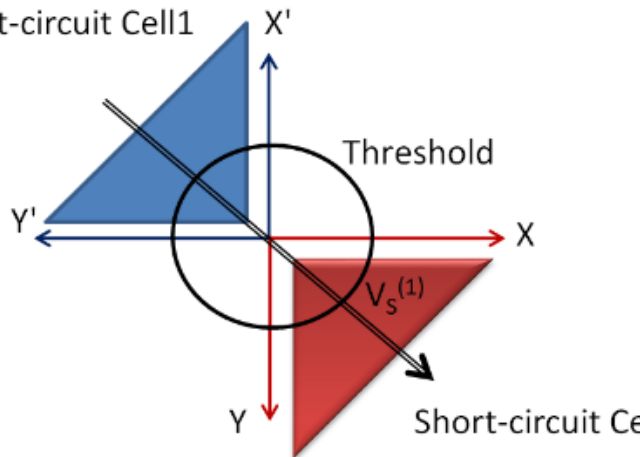
Figure 10. Location of the faulty cell by analyzing the fundamental phase of the input voltage. For ON-fault appearing on T : 1